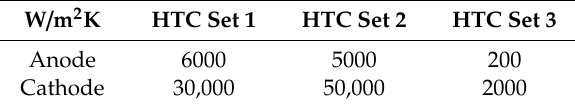
Table 1. Three heat transfer coefficient sets.